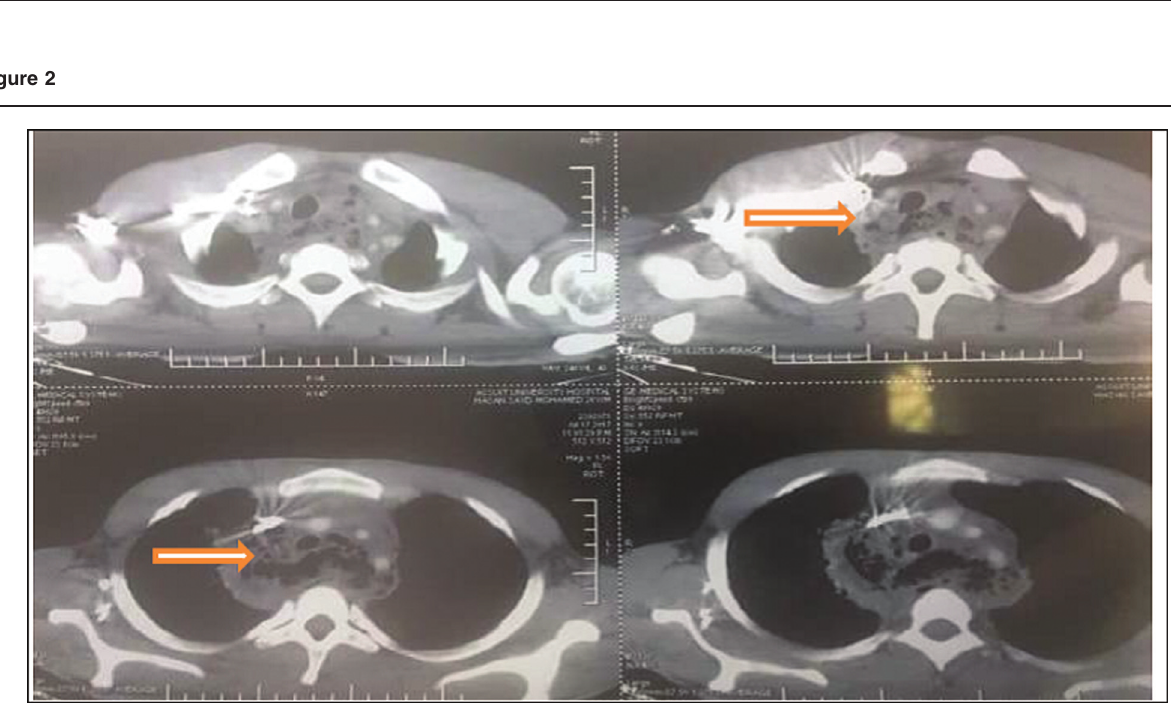
Computed axial tomographic scan of the chest showing a well-defined mass with air collection behind the anterior chest